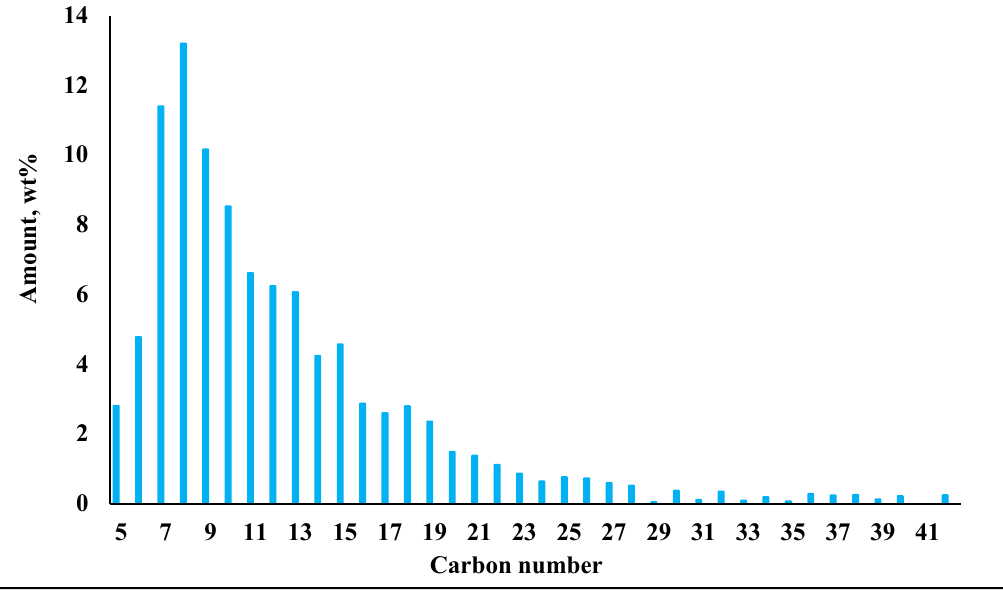
Figure 2. Carbon number distribution of crude oil.